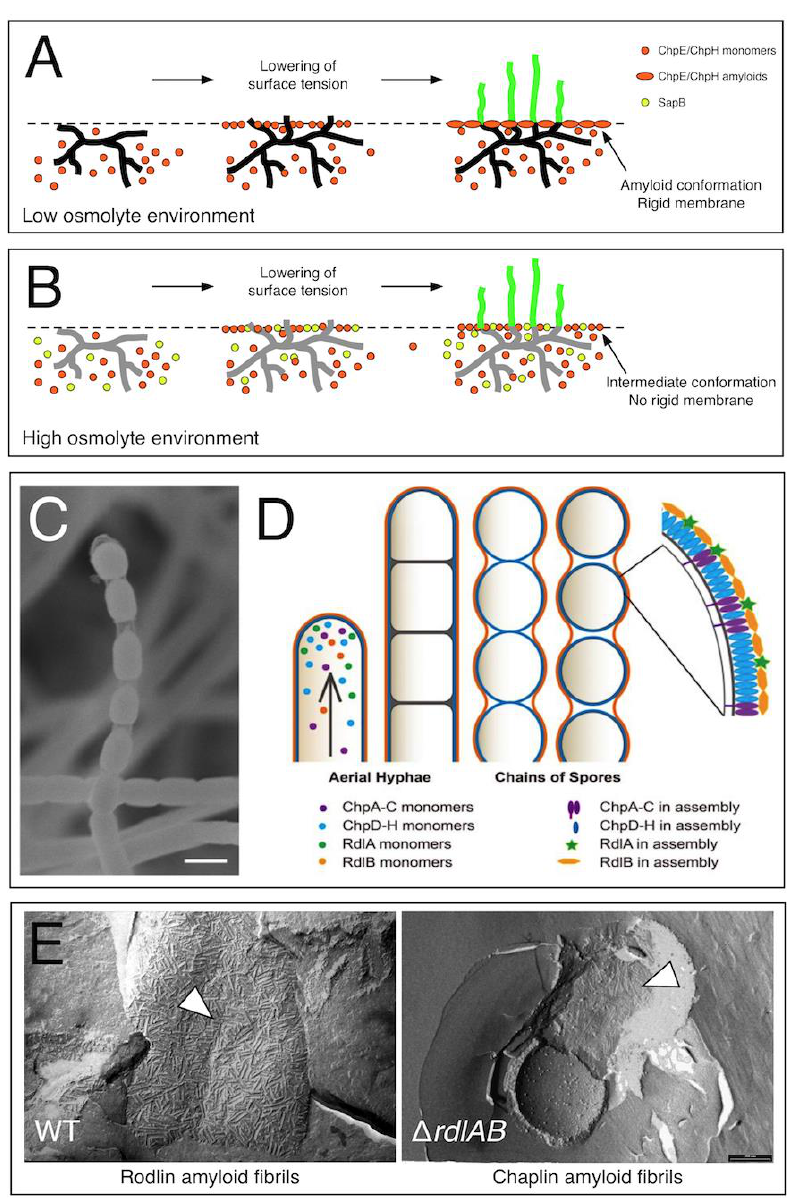
Figure 1. The role of chaplins and rodlins in aerial growth in Streptomyces coelicolor . The chaplins ChpE and ChpH are secreted by vegetative hyphae, and accumulate at the medium – air interface. Initial assembly of chaplins into a non-amyloidal membrane coincides with the lowering of the surface tension. When more chaplins accumulate at the interface, the transition to the amyloid state is induced. ( A ) In low osmolyte environments, hyphae have sufficient turgor pressure to penetrate this rigid membrane and grow into the air. ( B ) In high osmolyte-containing environments, the surfactant spore-associated protein (SapB) is produced in addition to ChpE and ChpH. The surfactant molecule SapB may intercalate into the chaplin membrane at the medium – air interface, thereby delaying or even preventing chaplins from assembling into a rigid amyloid membrane. This allows hyphae to grow into the air, even when their turgor pressure is reduced. Vegetative hyphae with a high turgor pressure are shown in black ( A ), while those with a reduced turgor pressure are shown in grey ( B ). ( C ) Visualization of spore chains using scanning electron microscopy reveals the presence of a transparent, sheath-like structure enveloping the separating spores. ( D ) This suggests that developing spore chains are surrounded by two distinct surface layers, containing assembled chaplins (purple/blue) and rodlins (green/orange). ( E ) The rodlins are part of the outermost surface layer, which has a more robust appearance (left panel) compared to the layer formed by the chaplins (right panel). Figure 1A,B was reproduced from reference [27] with permission from Springer (2014), while Figure 1C,D was reproduced from reference [28] with permission from the Nature Publishing Group